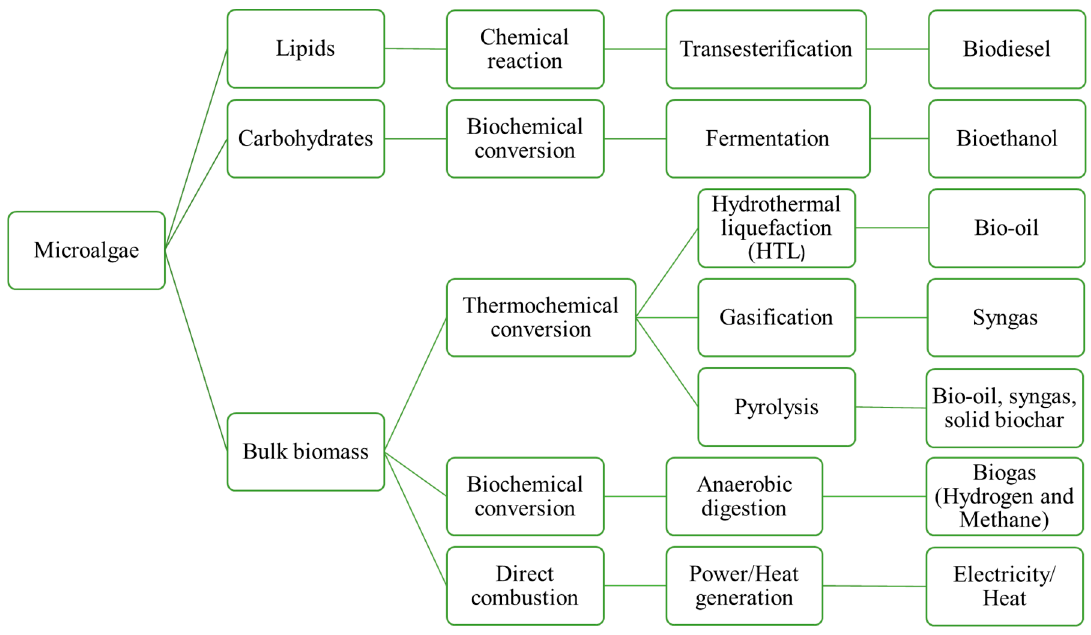
Figure 2. The conversion of microalgae into different biofuels.